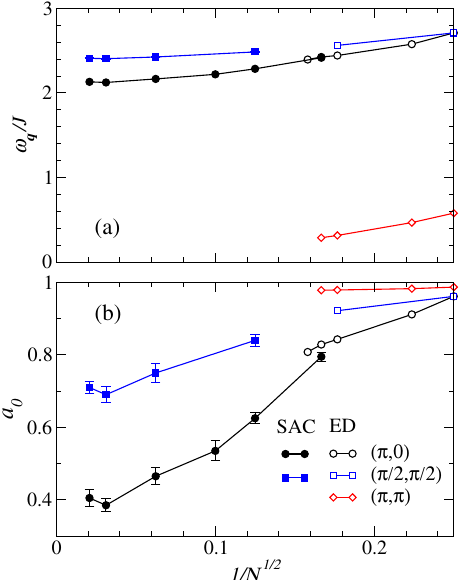
FIG. 7. Size dependence of the single-magnon energy (a) and weight in the magnon pole (b) at wave vectors q ¼ ð π ; 0 Þ , ð π = 2 ; π = 2 Þ , and ð π ; π Þ . Lanczos ED results for small systems ( L × L lattices with L ¼ 4 and L ¼ 6 as well as tilted lattices with N ¼ 20 , 32, and 40 sites) are shown as open circles, and QMC-SAC data are presented as solid circles with error bars. The error bars were estimated by bootstrap analysis (i.e., carrying out the SAC procedure multiple times with random samples of the QMC data